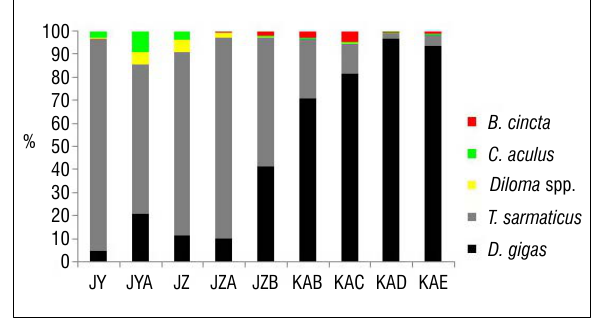
Figure 2: Relative abundance (%) per layer of the five most common shellfish species, based on weight, from Klipdrift Cave.